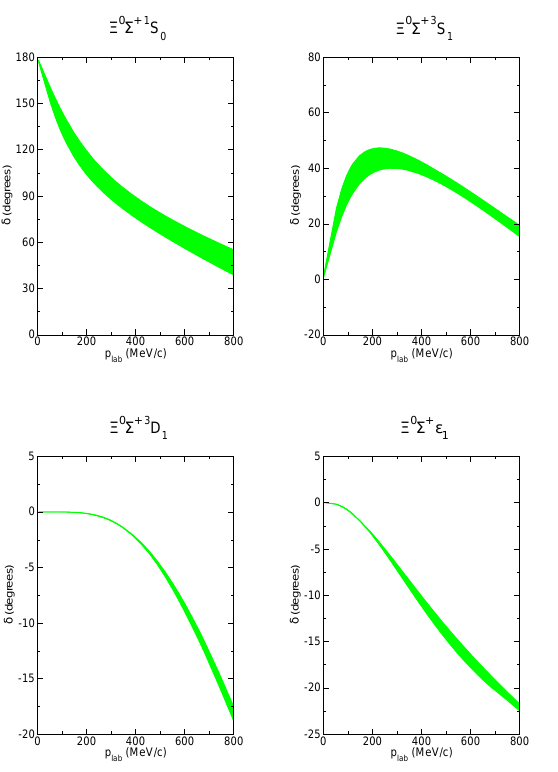
Fig. 7. Selected phase shifts for Ξ 0 Σ + . The shaded band shows the chiral EFT results to LO for variations of the cut-o ff in the range Λ = 550 . .. 700 MeV